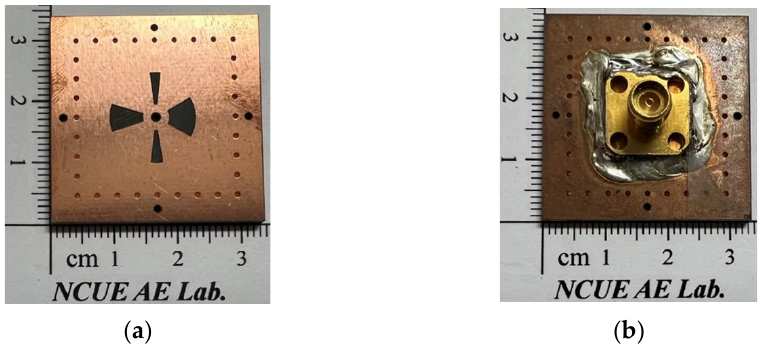
Figure 6. The photos of the experimental circuit’s SICC: ( a ) the coupling slots layer and ( b ) the bottom